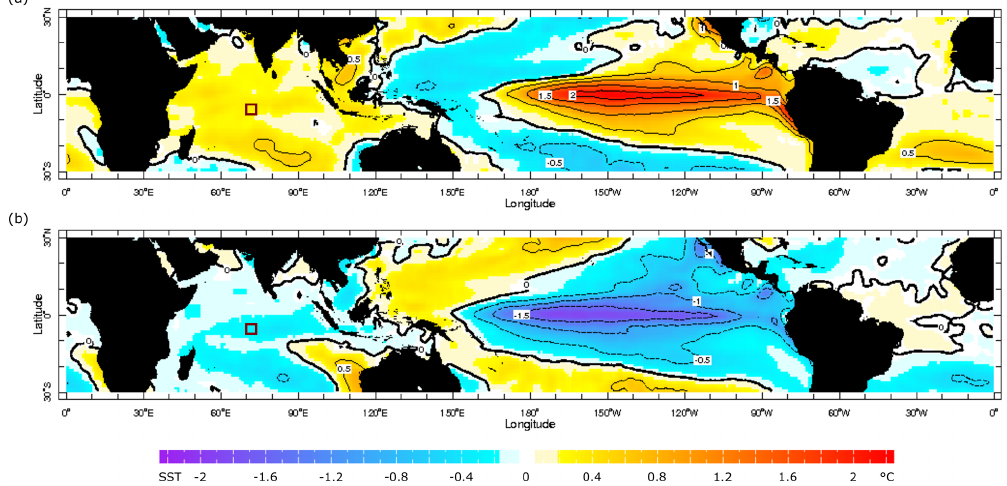
Figure 2. Composite maps of SST anomalies [ ◦ C] in the Indian and Pacific oceans during El Niño and La Niña events. (a) El Niño SST anomalies for the period from 1982 to 2016 averaged over December to February. Panel (b) is the same as panel (a) but for La Niña events. SST anomaly maps were computed with NOAA “Reynolds” OI v2 SST (Reynolds et al., 2002) using the free Data Views web application from the IRI Data Library (available at: https://iridl.ldeo.columbia.edu/, last access: 17 September 2018; IRI/LDEO, 2018). Red squares indicate the location of the study area. An overview of all events used for each composite map can be found in Table S1 in the